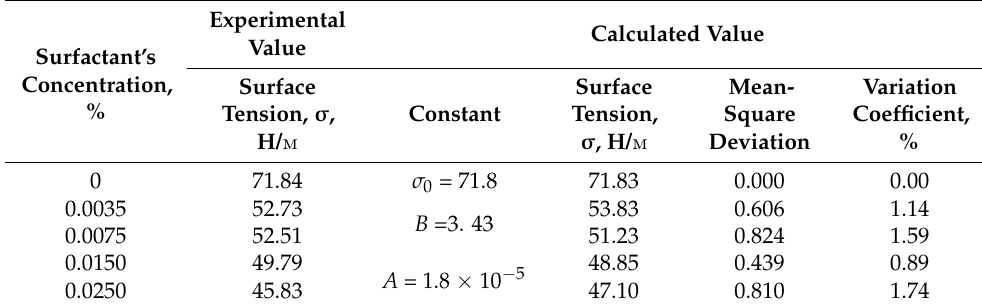
Table 5. Evaluation of applicability of Shishkovsky’s empirical equation for description of the impact of the Tensafor concentration on the surface tension of aqueous solutions.